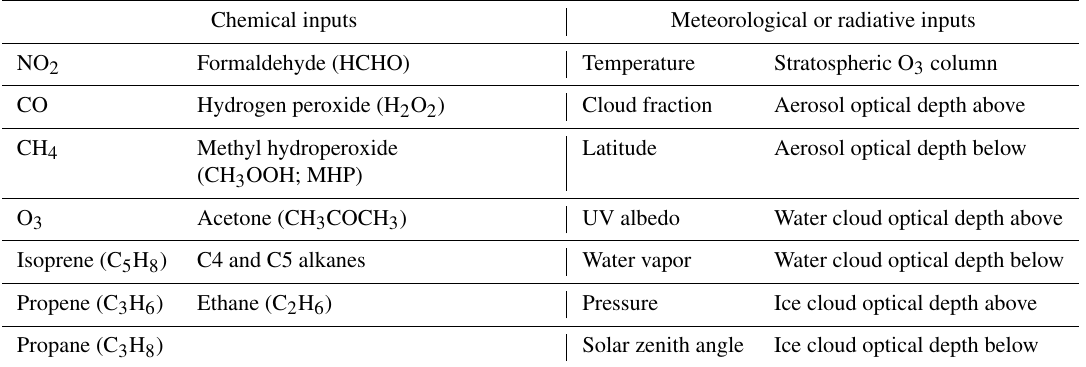
Table 1. Inputs to the machine learning parameterization of OH. UV albedo is the value at the surface. Cloud fraction is the fraction at a given model level. C4 and C5 alkanes are one input as they originate from a lumped variable in the GMI